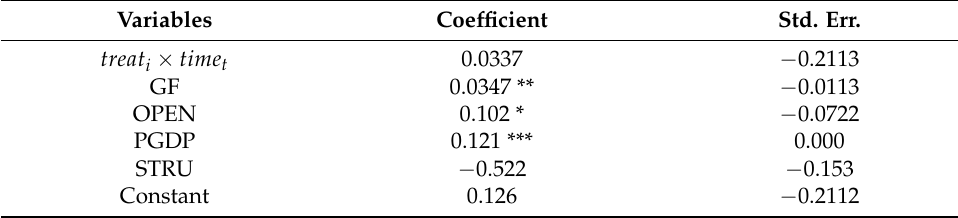
Table 7. Robustness